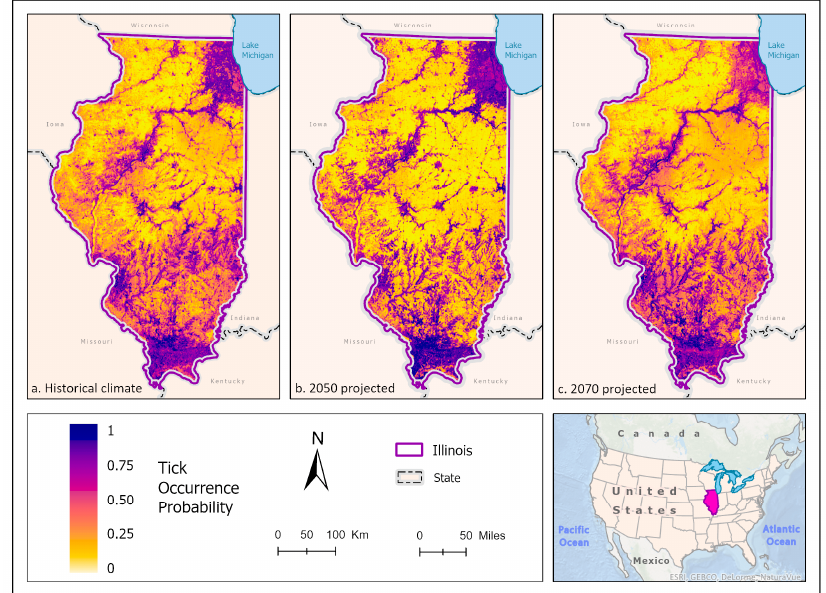
Figure 4. ( a ) Mean-weighted ensemble prediction of the probability of A. americanum occurrence in Illinois under historical climate conditions. ( b ) Mean-weighted ensemble of predicted probability of A. americanum occurrence in Illinois in 2050 projected climate Coupled Model Intercomparison Pro- ject phase 6 (CMIP6)/EC-Earth3-Veg Shared Socioeconomic Pathway (SSP) 585 (average from 2041 to 2060). ( c ) Mean-weighted ensemble of future predicted probability of A. americanum occurrence in Illinois in the 2070 projected climate (CMIP6)/EC-Earth3-Veg Shared Socioeconomic Pathway (SSP) 585 (average from 2061 to 2080). Darker colors indicate a higher likelihood of tick presence per the tick occurrence probability scale. Inset map indicates the location of Illinois within the United States/North America.